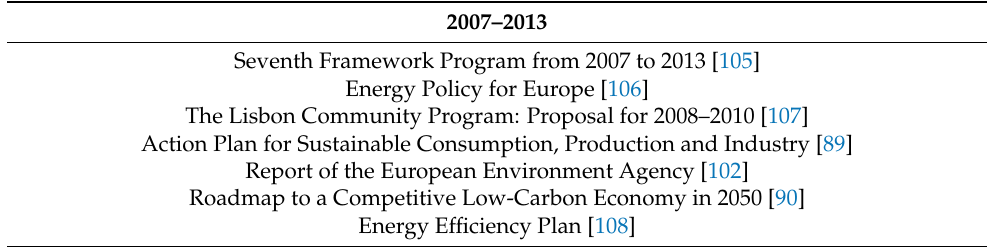
Table 8. Legislation of the European Union from 2007 to 2013.